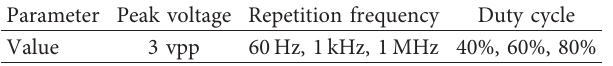
Table 2: Pulse signal parameter setting.